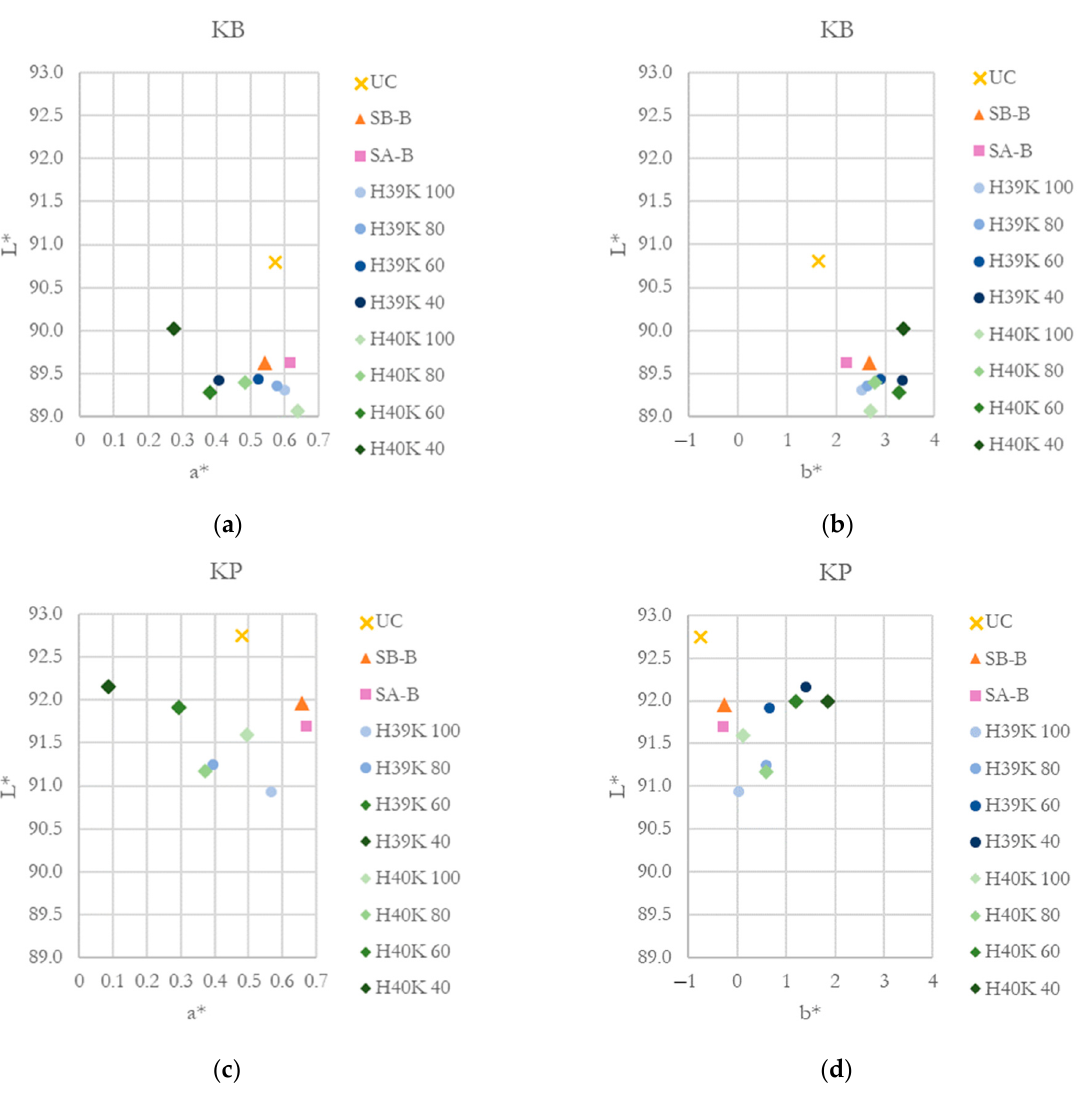
Figure 8. CIE L*a*b* coordinates for the investigated substrates and coatings. ( a ) and ( b ) L*-a* and L*-b* coordinated for the KB substrate. ( c ) and ( d ) L*-a* and L*-b* coordinated for the KP substrate.